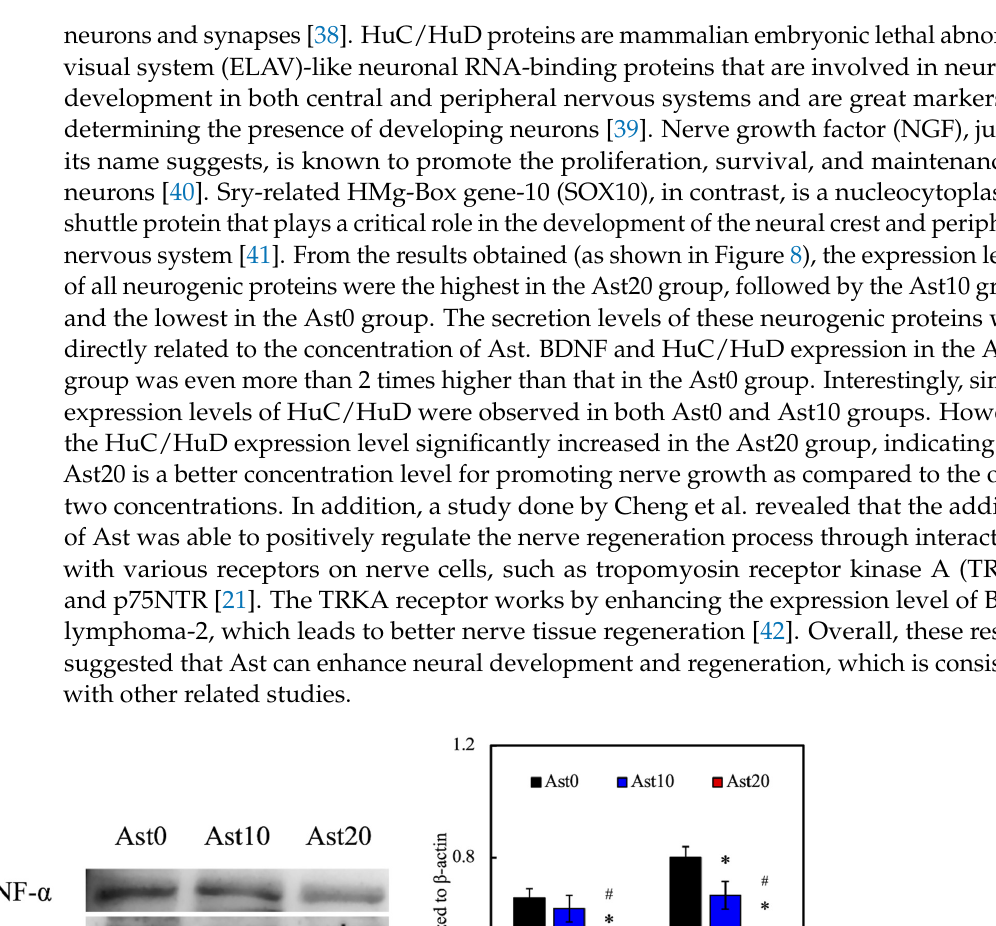
Processes 2021 , 9 , x; doi: FOR PEER REVIEW